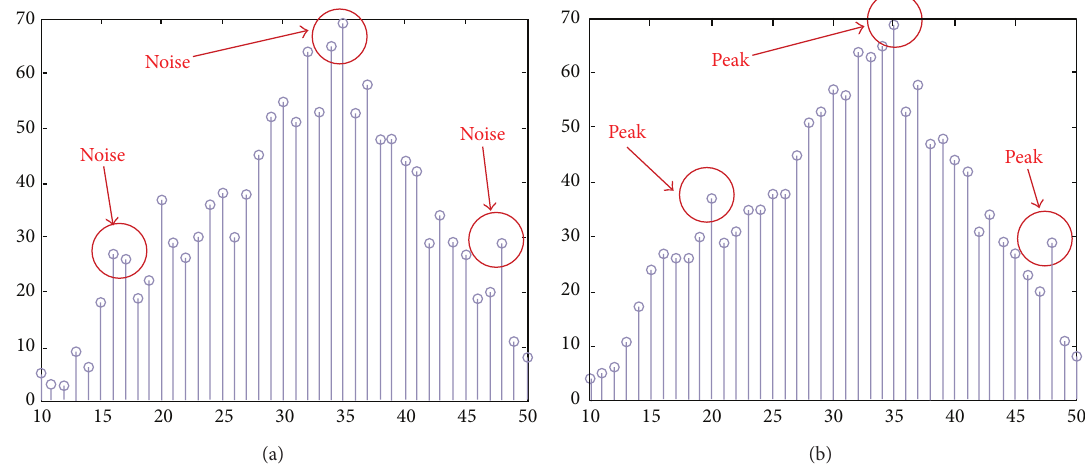
Figure 5: (a) Histogram obtained after performing URGA Step 2, with noise values framed in circles, and (b) the histogram after performing the mean filter.